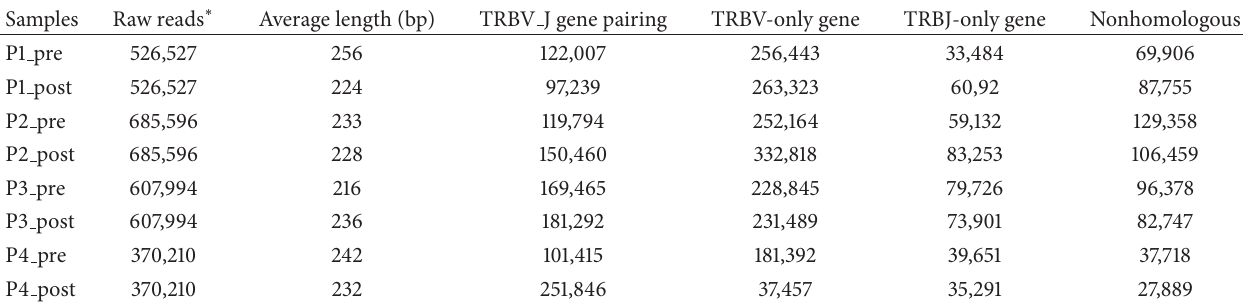
Table 2: The number of raw sequencing reads and the rearranged TRBV J clones.